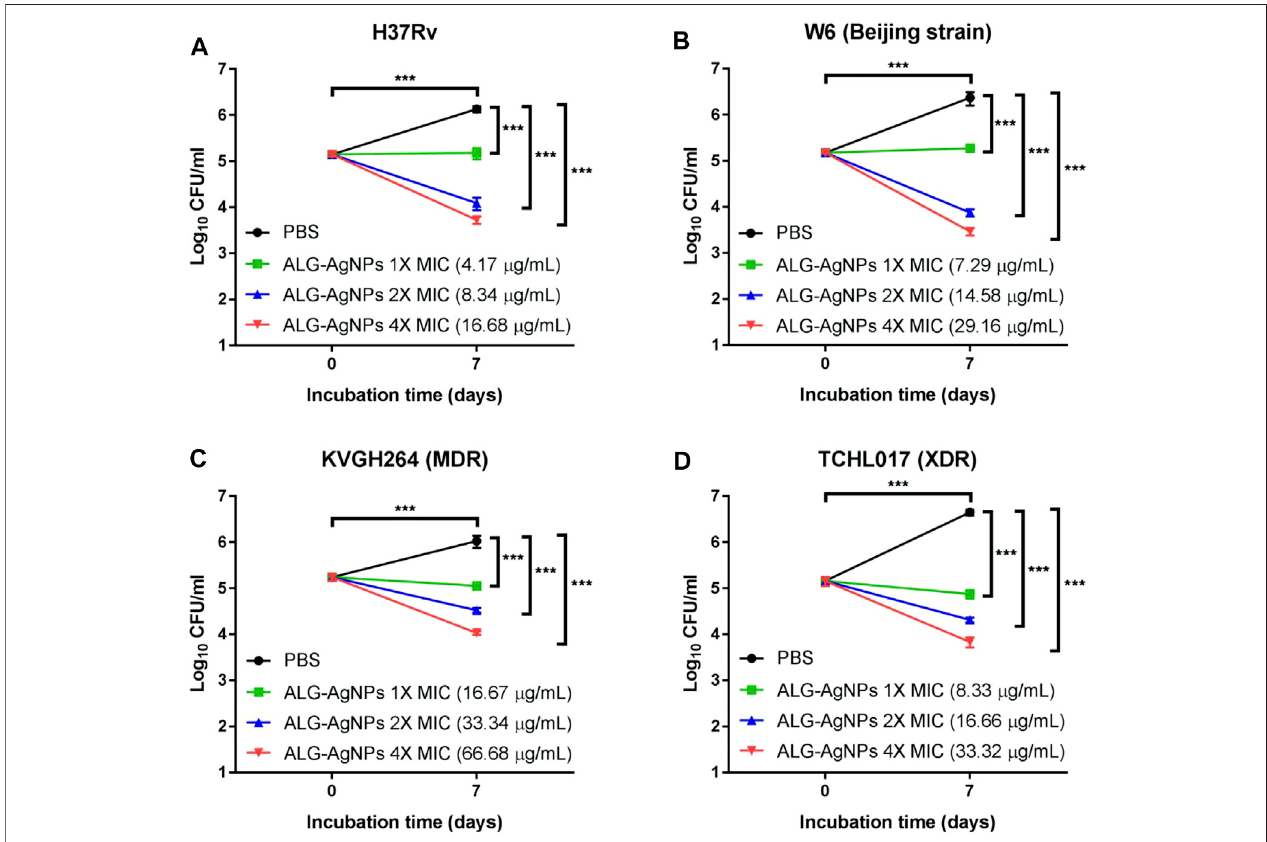
FIGURE3| ThebiocidalactionofALG-AgNPsagainstdifferent Mtb strainsmeasuredasasuppressionofcolonynumbersrelativetoPBStreatment(control).Four Mtb strainswereincubated withPBSordifferentamounts ofALG-AgNPsfor0and 7 days.Bacterialgrowth wasdeterminedbycountingthecolonyforming units(CFU) of (A) H37Rv (standard reference strain), (B) W6 (Beijing strain), (C) KVGH264 (MDR), and (D) TCHL017 (XDR). MDR: Multidrug-resistant TB; XDR: extensively drug- resistant TB. The data are expressed as log 10 CFU/ml and represent the mean ± SEM of 3 experiments. *** p <